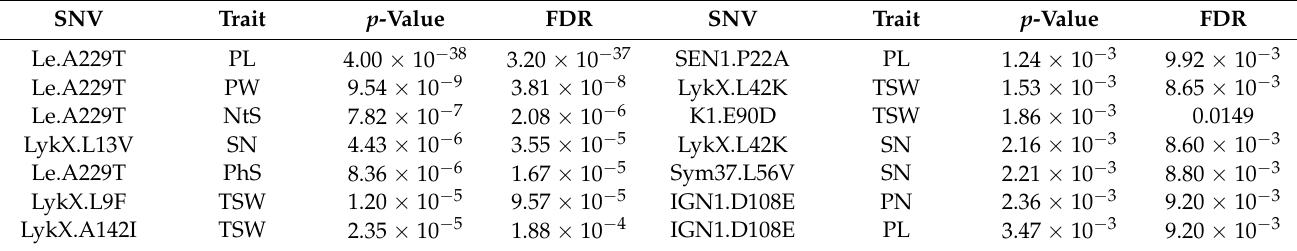
Table 5. Associations between SNVs and